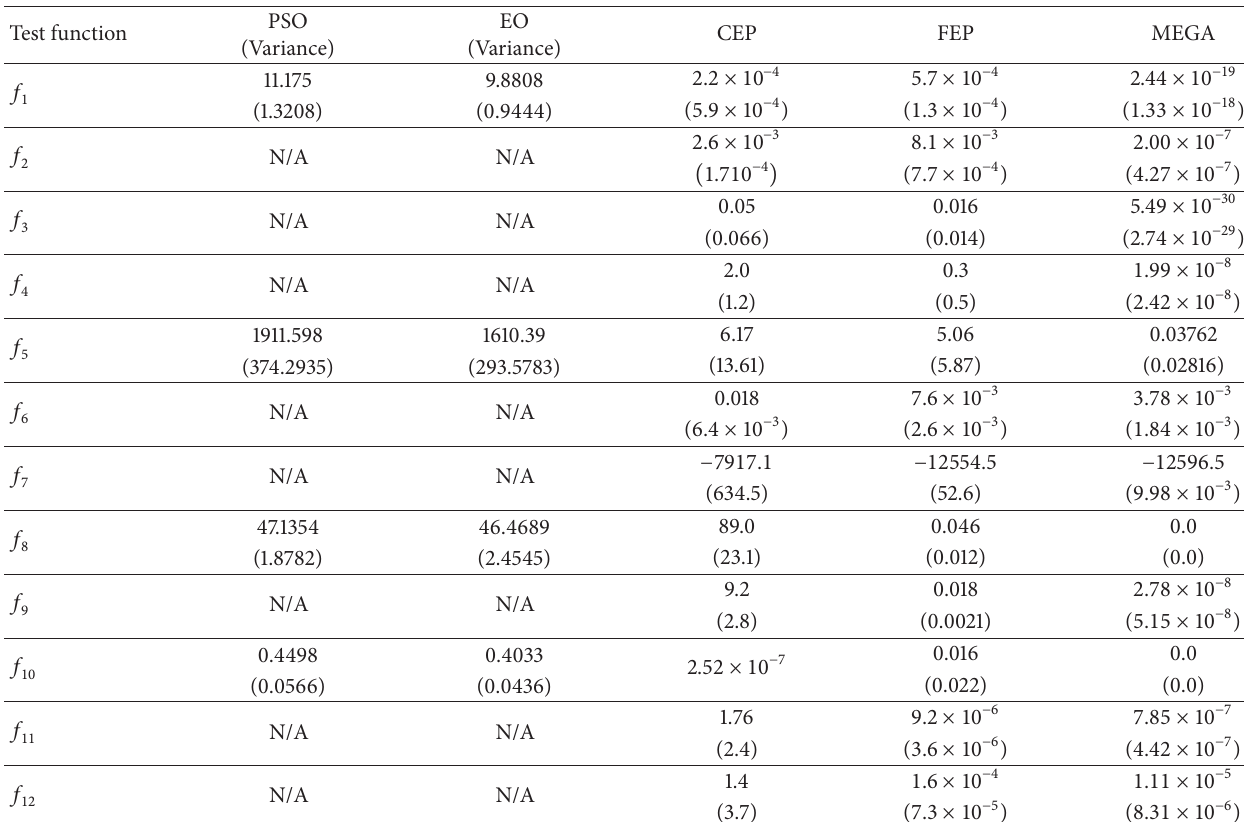
Table 3: Comparison of the mean best value (and Std Dev) with other